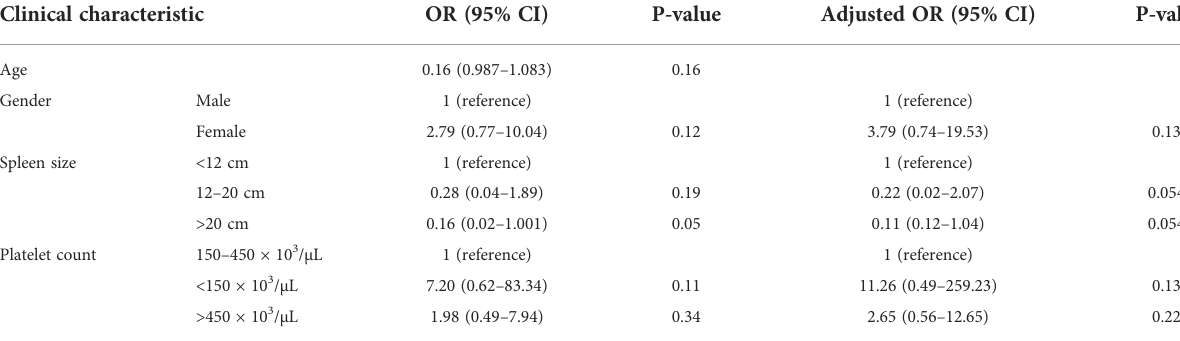
TABLE 3 Risk association of clinical parameters at diagnosis with the disease progression in CML patients. Clinical characteristic